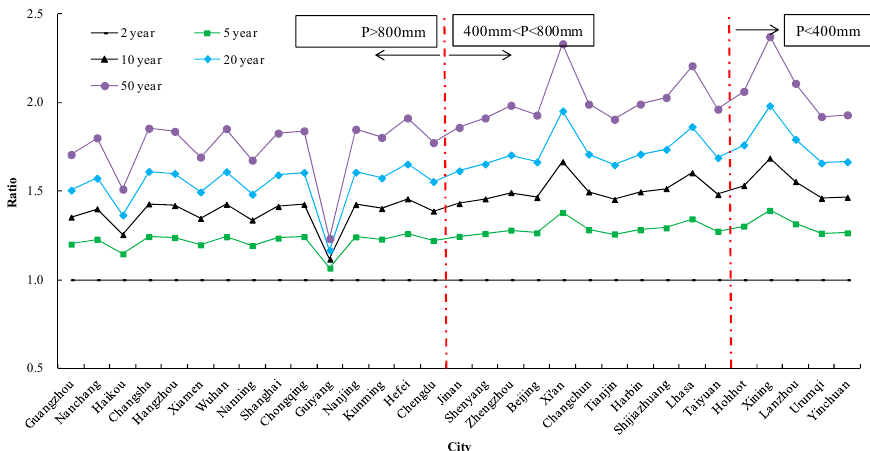
Figure 7. Ratio of rainfall intensity at different recurrence interval over rainfall intensity of 2-year recurrence interval in different climatic areas.